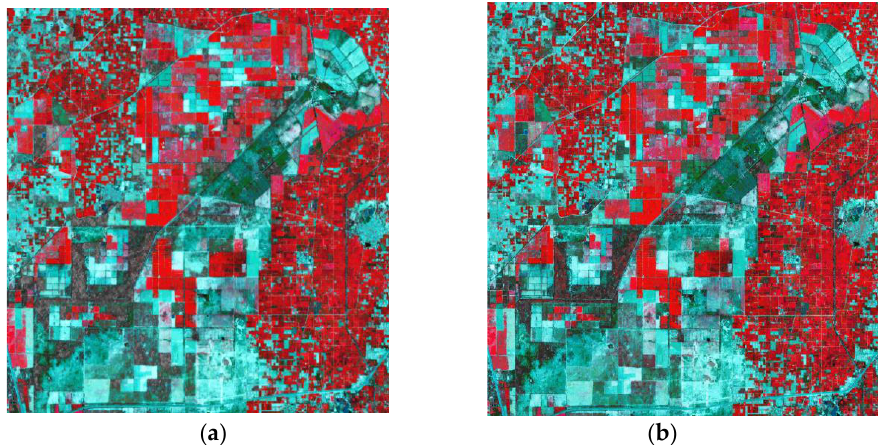
Figure 3. Sentinel 1A (S1) and Sentinel 2B (S2) fused images using GIV approach by ( a ) VH and ( b ) VV polarization.